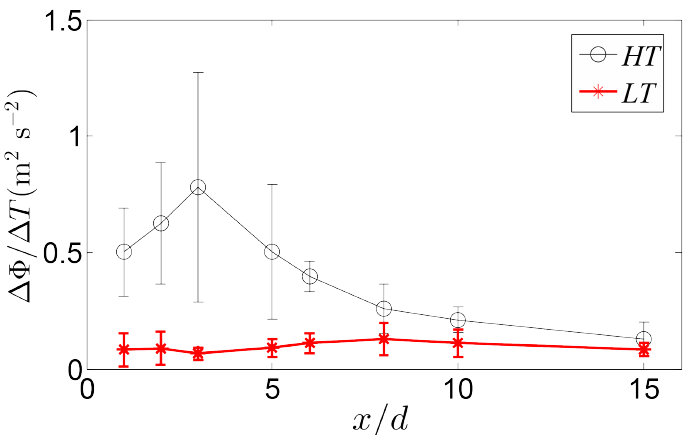
Figure 10. Energy decay rate of large-scale flow structures as a function of downwind distance for the HT and LT cases. Note that this energy decay rate was obtained by reconstructing low-pass filtered time series for the scales between maximum energy observed in velocity spectra (Figure 3) and the integral length scales. The vertical lines show the error bars represented by ± 1 standard deviation. Note the increase in the mean and standard deviation in the HT wake and the decrease in the LT wake at x / d ∼